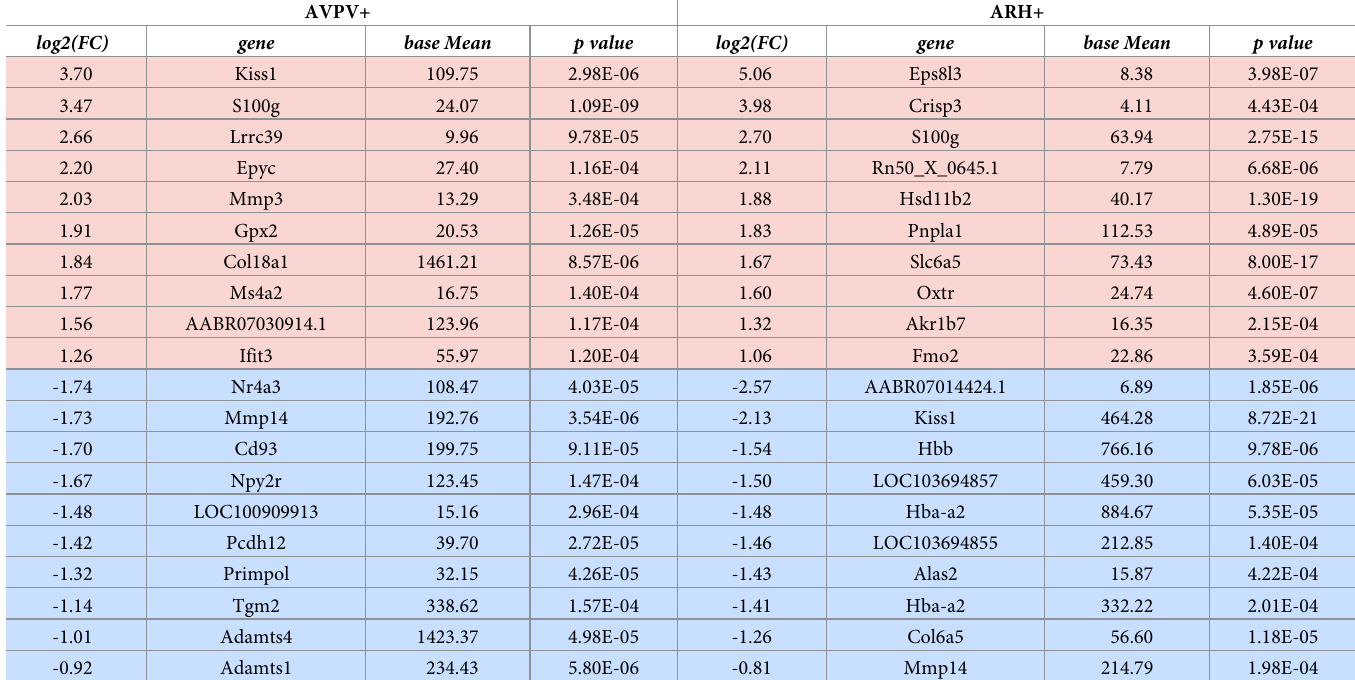
Table 2. Top DE genes baseline vs 6 hrs post-